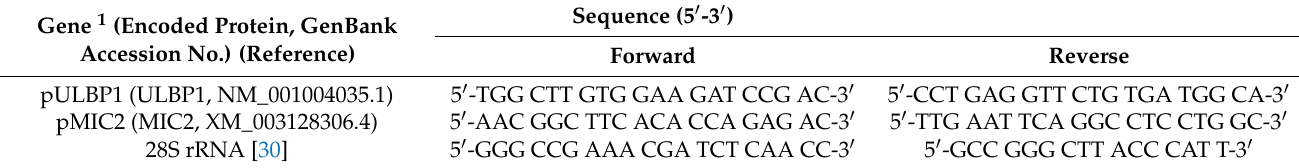
Table 2. Forward and reverse primers used for RT-qPCR